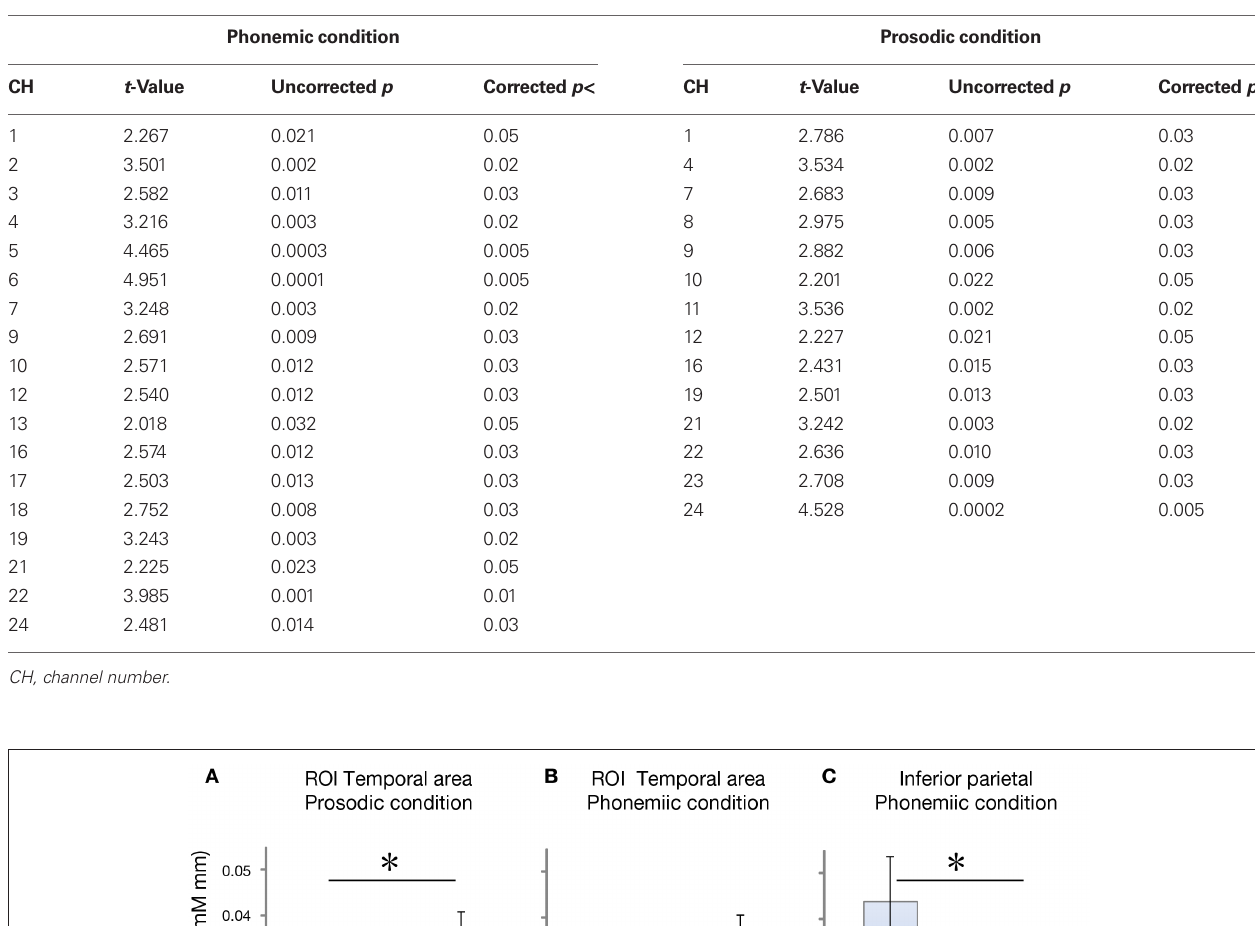
Table 1 | Statistic results of significant